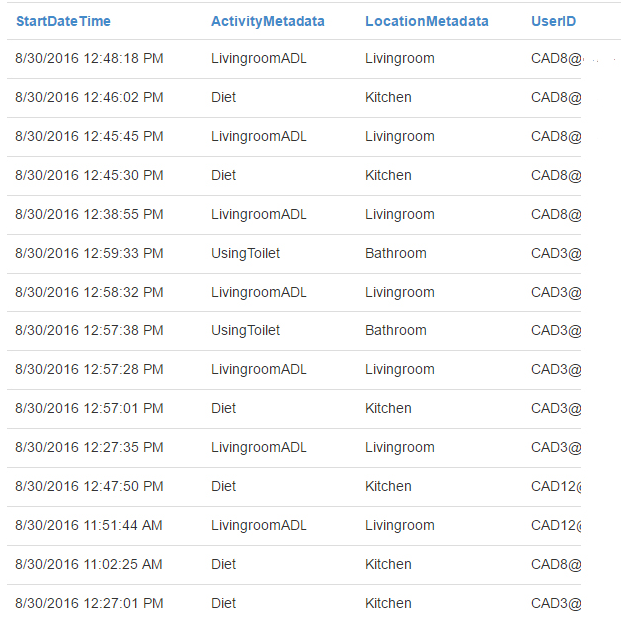
Figure 4. A screenshot of